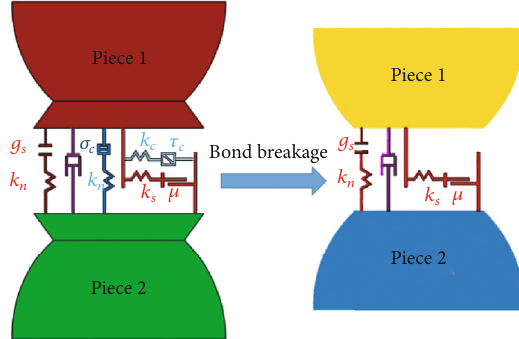
Figure 1: Parallel bond model: (a) parallel bond; (b) bond failure